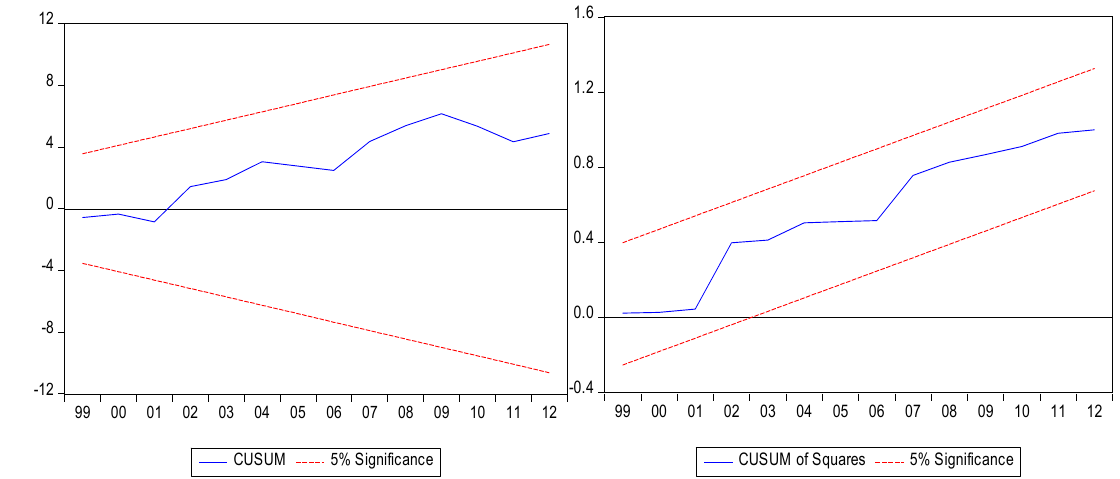
Figure 7. CUSUM and CUSUM of squares test for the cubic model.